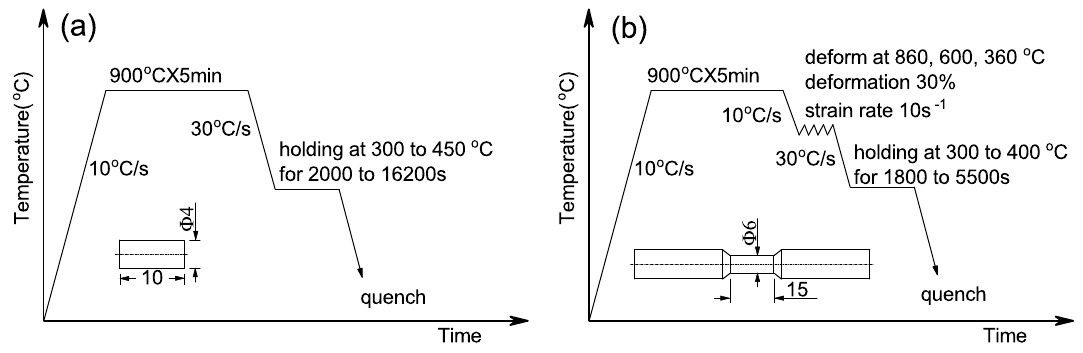
Figure 1. Schematic illustration of experimental process. ( a ) Isothermal transformation of undeformed austenite; ( b ) Isothermal transformation of deformed